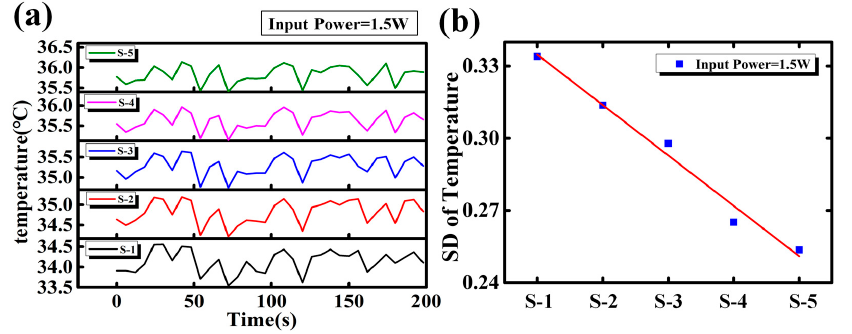
Figure 4. ( a ) Transient temperature responses at different locations for Case I (input power = 1.5 W) and ( b ) standard deviations of temperatures along the micro channel from inlet to outlet (S-1 to S-5).